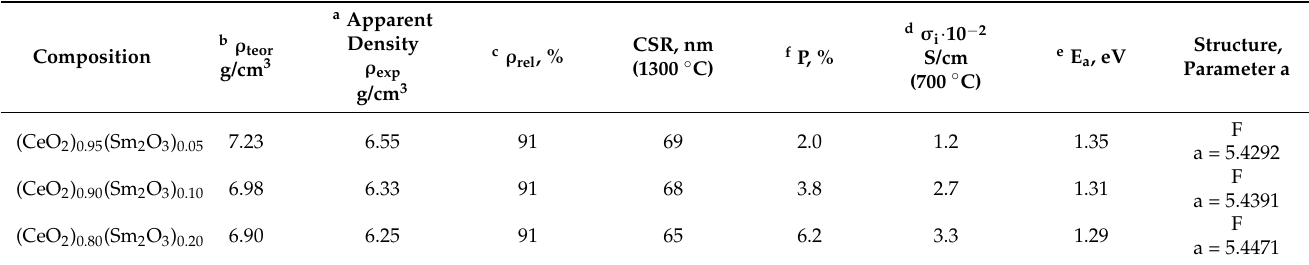
Table 2. Physicochemical properties of (CeO 2 ) 1-x (Sm 2 O 3 ) x (x = 0.05; 0.10; 0.20) ceramics samples synthesized by co-precipitation.